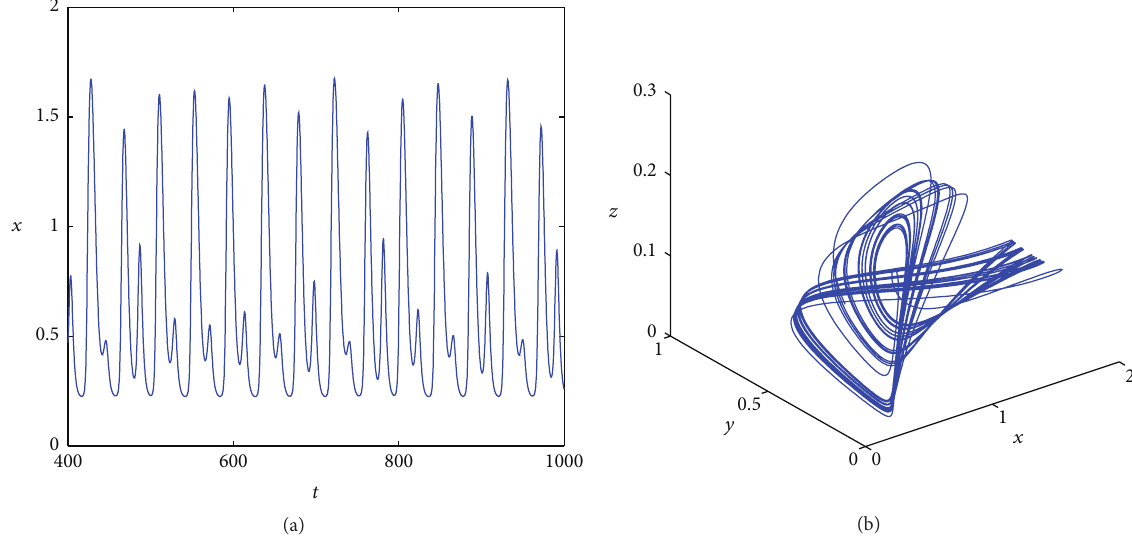
Figure 2: Schematic diagram of a chaos attractor when 𝜔 = 2.0 , 𝐴 = 0.2 , 𝑏 = 0.5 , 𝑐 = 0.1 , 𝑑 = 0.2 , ℎ = 1.0 , 𝛽 = 2 , 𝛼 = 0.6 , and 𝑚 = 0.2 . (a) The time evolution of resource 𝑥 . (b) The 3D phase of the attractor.